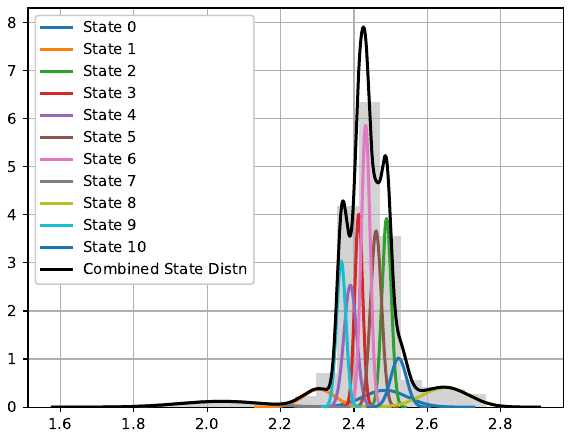
Figure 8. The histogram of the occurrence of each (log) demand level of the original time series (gray bars) together with the state distributions and the stationary joint probability distribution (solid black curve) for the